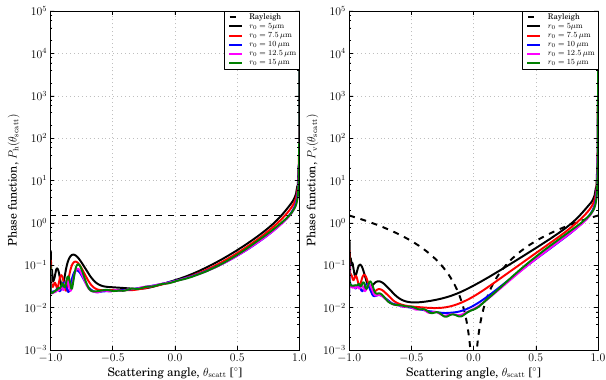
Figure 4. Phase functions P h (θ scatt ) and P v (θ scatt ) as a func- tion of scattering angle θ scatt for distributions with median radii r 0 = 5 , 7 . 5 , 10 , 12 . 5 and 15µm, respectively, each with a width σ 0 = 1 . 13. The refractive index in each case is n = 1 . 33 − 0 . 0 ı . The dashed line shows the corresponding Rayleigh scattering phase functions.